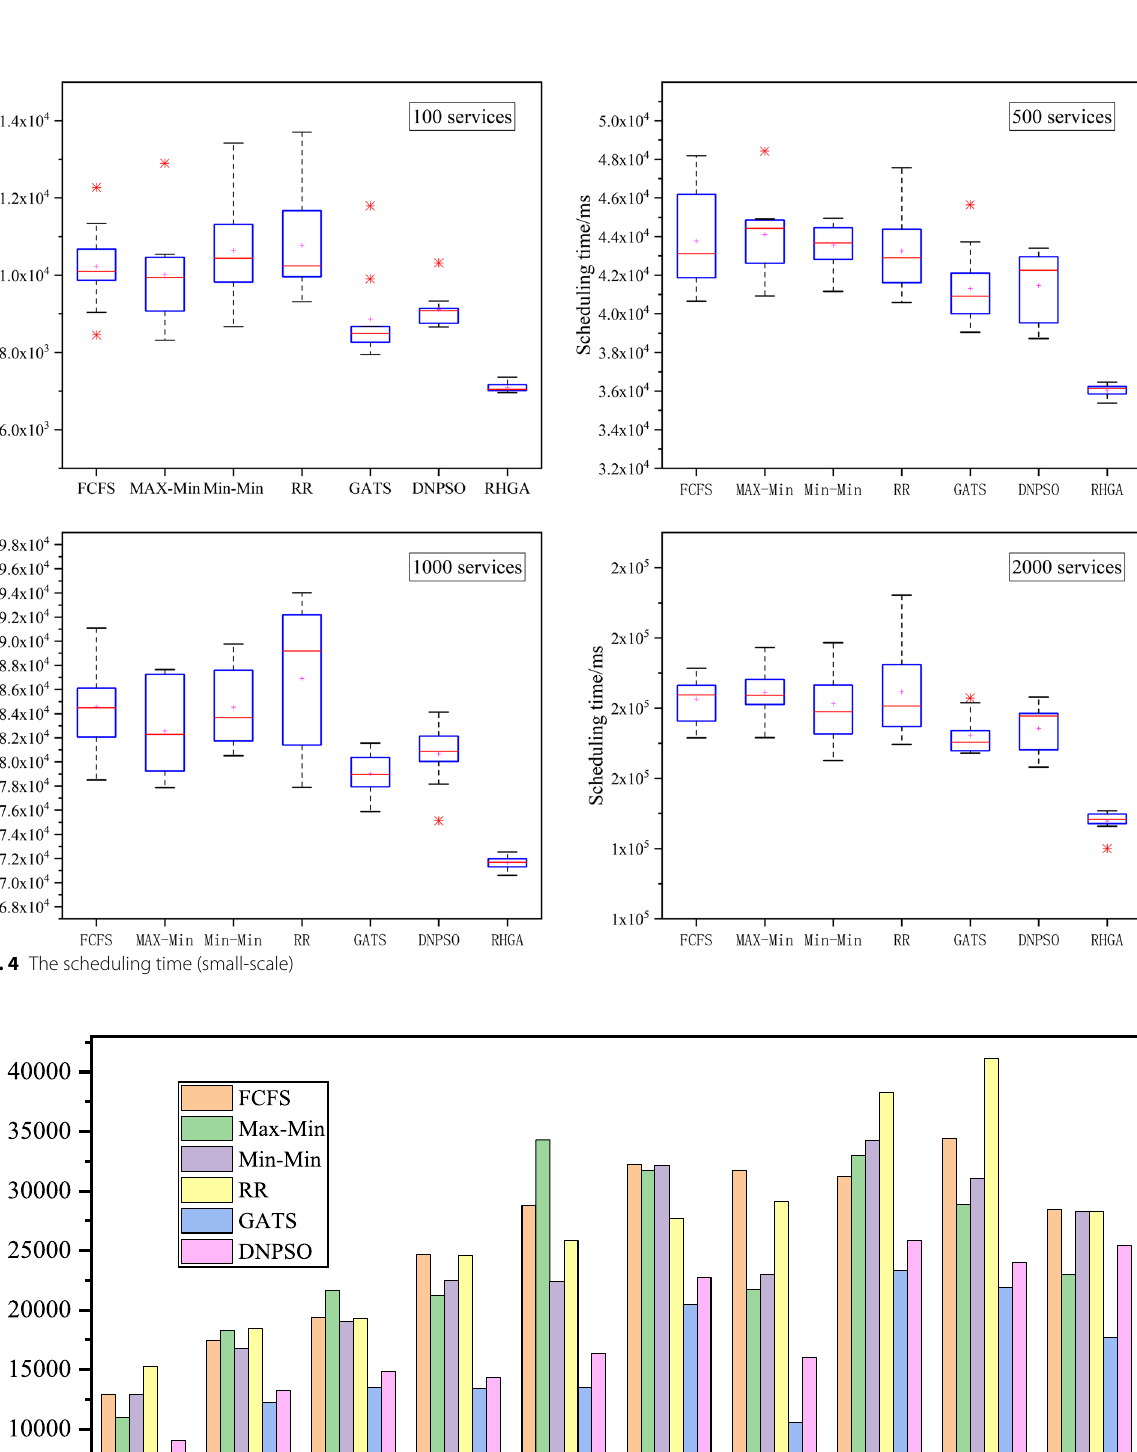
Fig. 5 The numerical difference of scheduling time